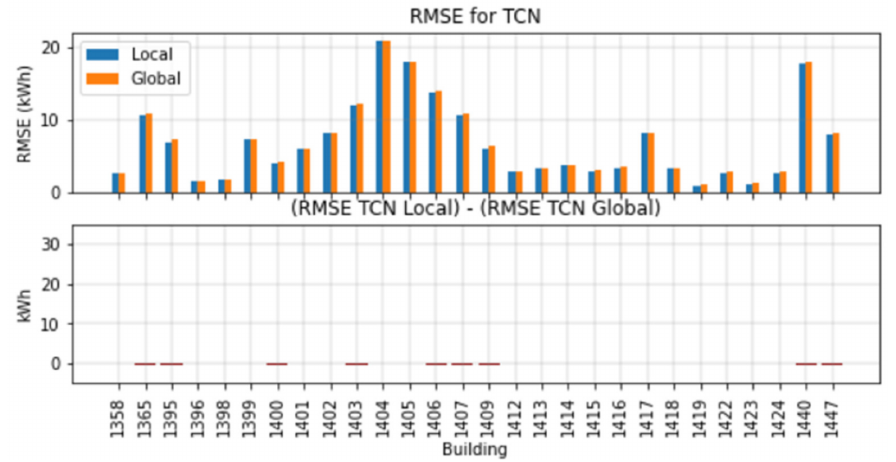
Figure 8. Comparison (in the upper figure) and difference (in the lower figure) between the RMSE obtained from local and global TCN models on test